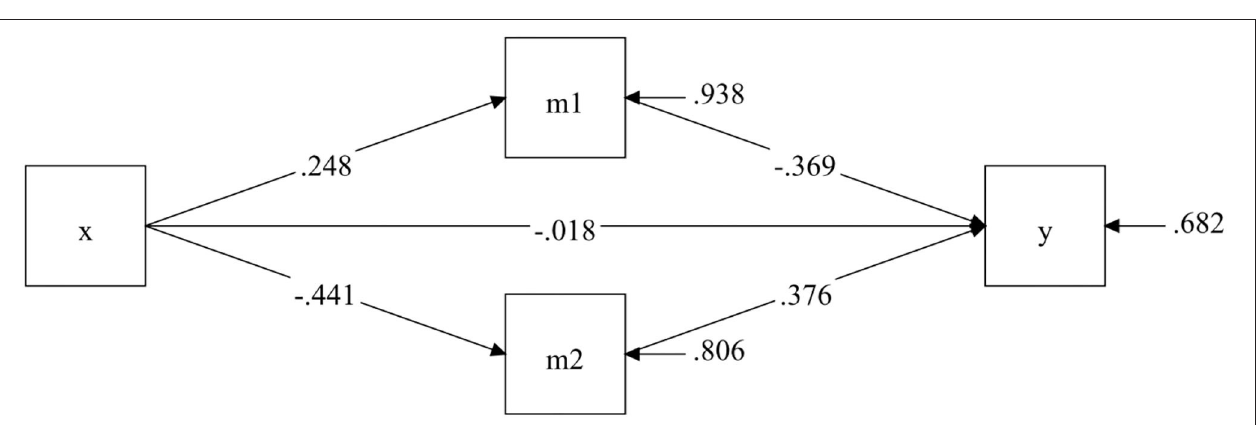
FIGURE 4 | The mediating model after 18-week